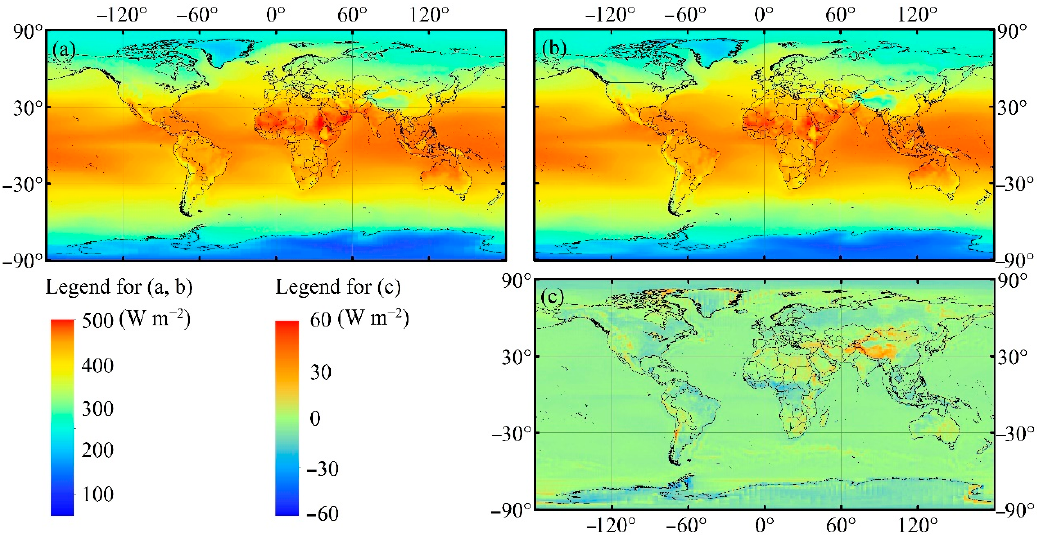
Figure 12. Spatial variation in the CERES EBAF SULR estimations ( a ), ERA5 SULR estimations ( b ), and the biases between CERES EBAF and ERA5 ( c ) from 2000 to 2005 (in units of W m − 2 ).